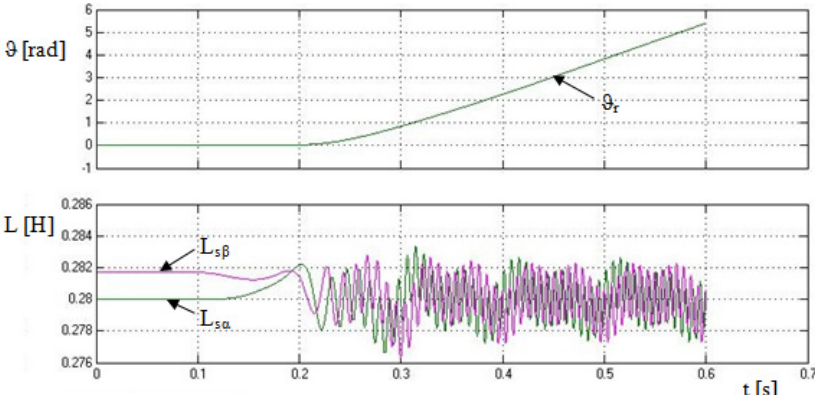
Figure 15. Course of change of LS with NSS and NSDR during engine start-up . Other components are alternating quantities; however, the first two of them are al- most identical in amplitude. They represent a change in inductance due to the NSS influ- ence. Since they are the second and fourth order harmonics, their frequencies are 10 and 20 Hz, shown in Figure 16. The last, fourth component represents the asymmetry created by the rotor slotting. As already mentioned, its working frequency is directly proportional to the multiple of the rotor rotation frequency and the number of rotor teeth. Thus, the frequency of this inductance change also changes with the motor load. Figure 16. Frequency spectrum of stator inductance . 7. Process of Asymmetry Elimination Due to Saturation A process similar to the one in Section 6 will be used to estimate the rotor position. The problem is that the transformed high-frequency signal now carries information not only about the position of the NSDR but also about the position of the NSS. Thus, these introduce great inaccuracy into the rotor position estimation (Figure 17) mainly because they also depend on the stator current amplitude.